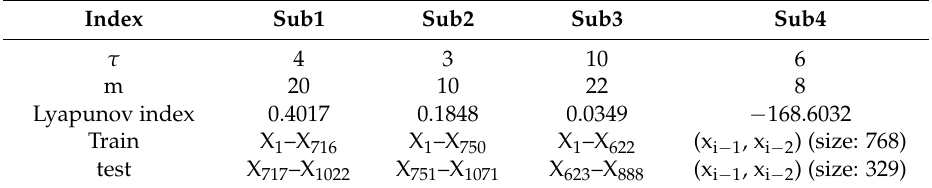
Table A5. The parameters of each subsequence decomposed by FEEMD of the Shenzhen carbon